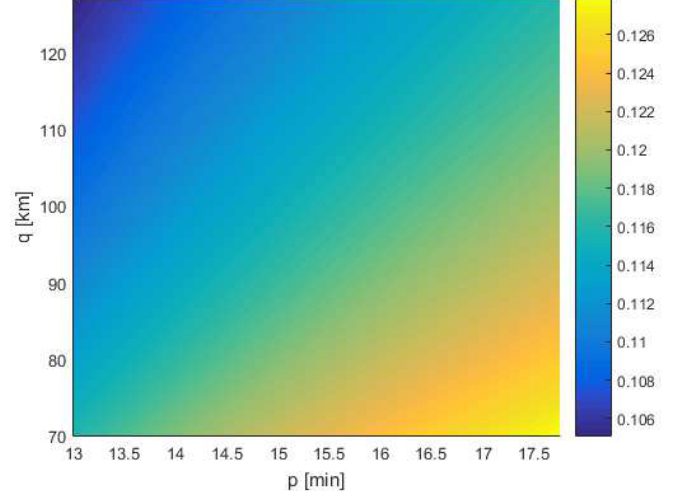
Figure 12. Interception time t f as a function of p and q for minimized J 2 index (2D